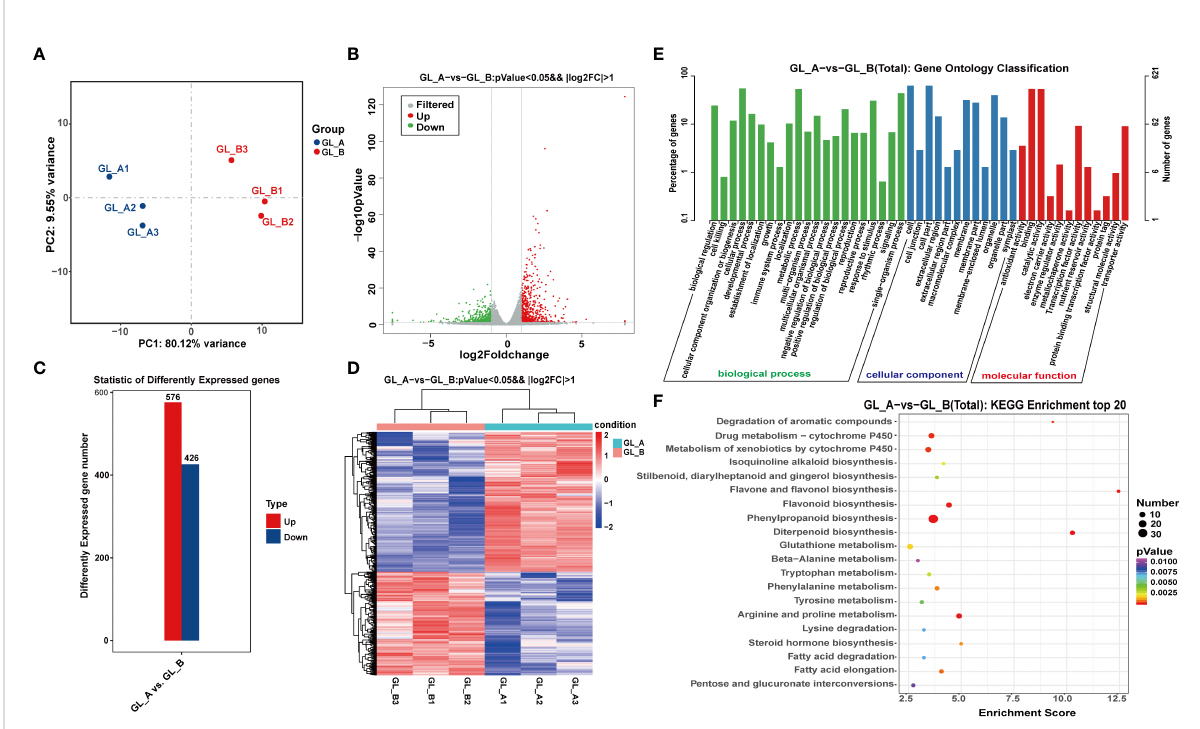
FIGURE 2 Screening and analysis of the GA 3 -treated Sorghum ( “ Jitian 3 ” ) mRNA with under salt stress. (A) Principal Component Analysis (PCA) of GA 3 - treated (GL_A) and control (GL_B) samples; Blue dots represent GL_A samples, and red dots represent GL_B samples. (B) A volcano plot displaying the differentially expressed mRNAs (DE-mRNA) between the GL_A (n = 3) and GL_B groups (n = 3) based on RNA-seq analysis. Red dots represent upregulated DEGs; green dots represent downregulated DEGs; dotted line represents a screening threshold for DEGs; the x-axis values correspond to the log2 (fold change) value; the y-axis corresponds to the mean expression value of the − log10 (p-value) between the GA 3 -treated (GL_A) and control (GL_B) groups (fold change = GL_A/GL_B). (C) Statistical analysis of the DE-mRNAs in the GL_A and GL_B samples. (D) Hierarchical cluster analysis of DE-mRNAs among the six mRNA sequencing libraries; Red indicates upregulation, while blue indicates downregulation. GL_A1, GL_A2 and GL_A3 represent the three replications of GA 3 -treated samples; GL_B1, GL_B2 and GL_B3 represent the three replications of control samples. (E) gene ontology (GO) enrichment analysis; The x-axis shows the second level GO terms from the biological process (BP), cellular component (CC) and molecular function (MF) while the y-axis shows the number and percentage of gene enrichment. (F) Kyoto encyclopedia of genes and genome (KEGG) network enrichment analysis of DE-mRNAs. The x-axis showed an enrichment factor and the y-axis showed the pathway name; the point size represents the number of DE-mRNAs and the point color represents the p-value